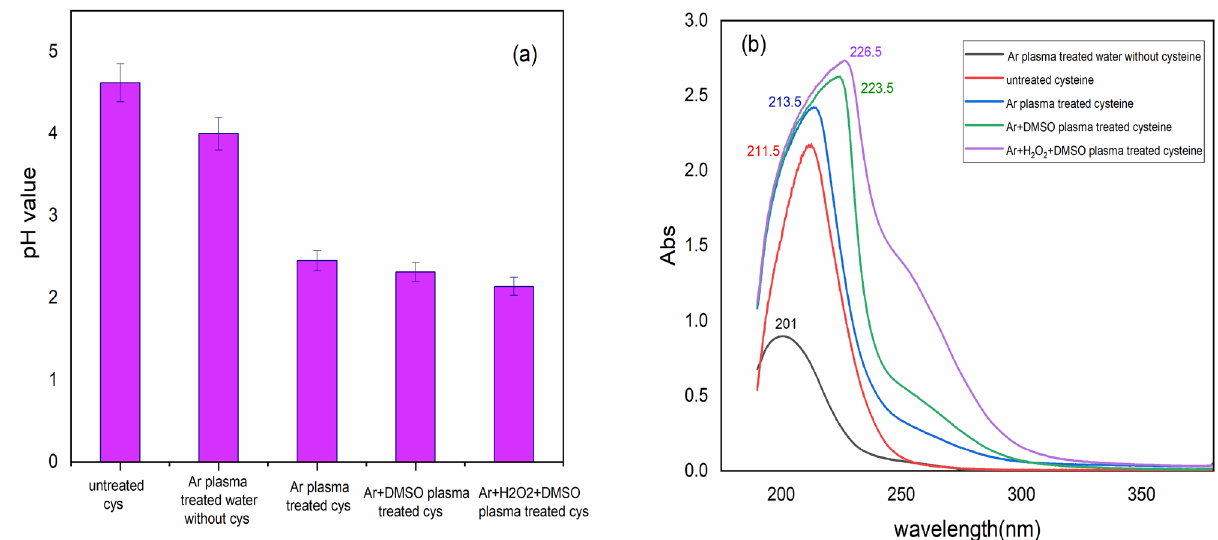
Figure 2. ( a ) Comparison of the pH value of untreated cysteine solution with different plasma-treated samples and ( b ) UV–Vis absorption spectra of cysteine solution and different types of TSP-treated